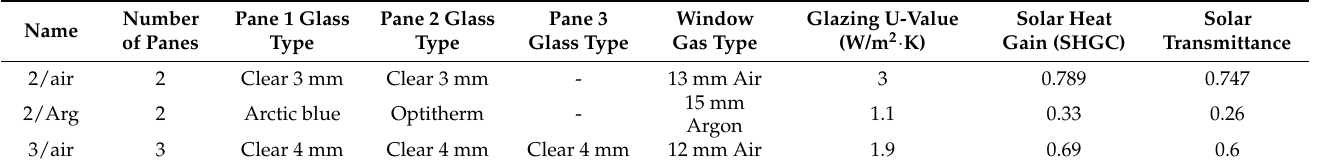
Table 2. Properties of the windows used for different case studies.